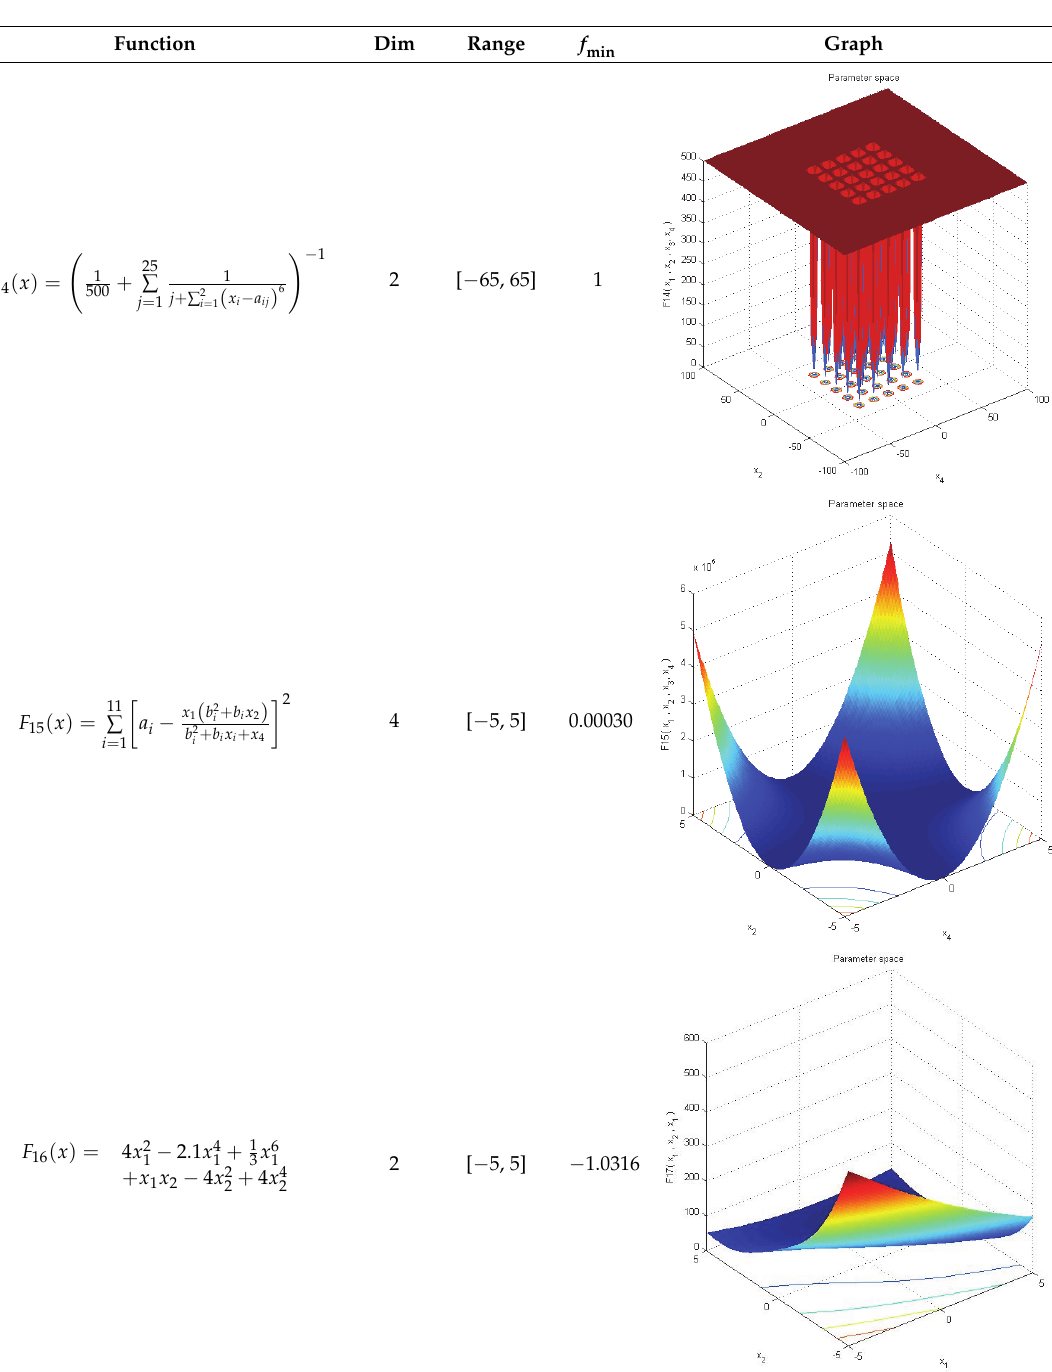
Table 3. Fixed ‐ dimension multimodal benchmark functions.